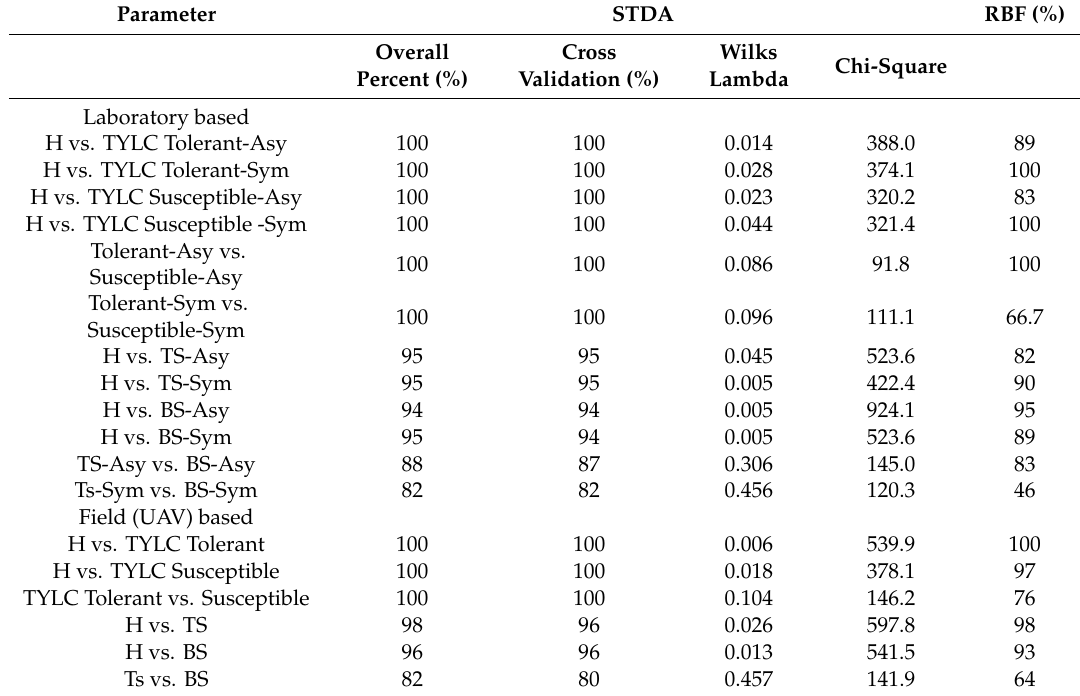
Table 2. Classification results utilizing the stepwise discriminant analysis (STDA) and the radial basis function (RBF) for TYLC-, BS-, and TS-infected tomato plants in symptomatic (Sym) and asymptomatic (Asy)